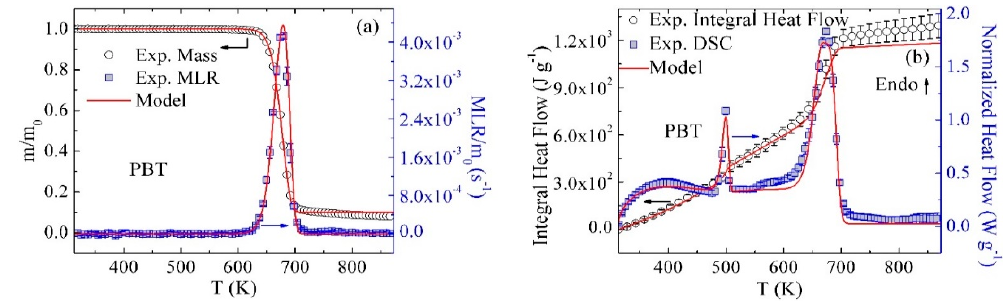
Figure 7. Experimental and simulated ( a ) TGA and ( b ) DSC data obtained for pure PBT at 10 K min − 1 .